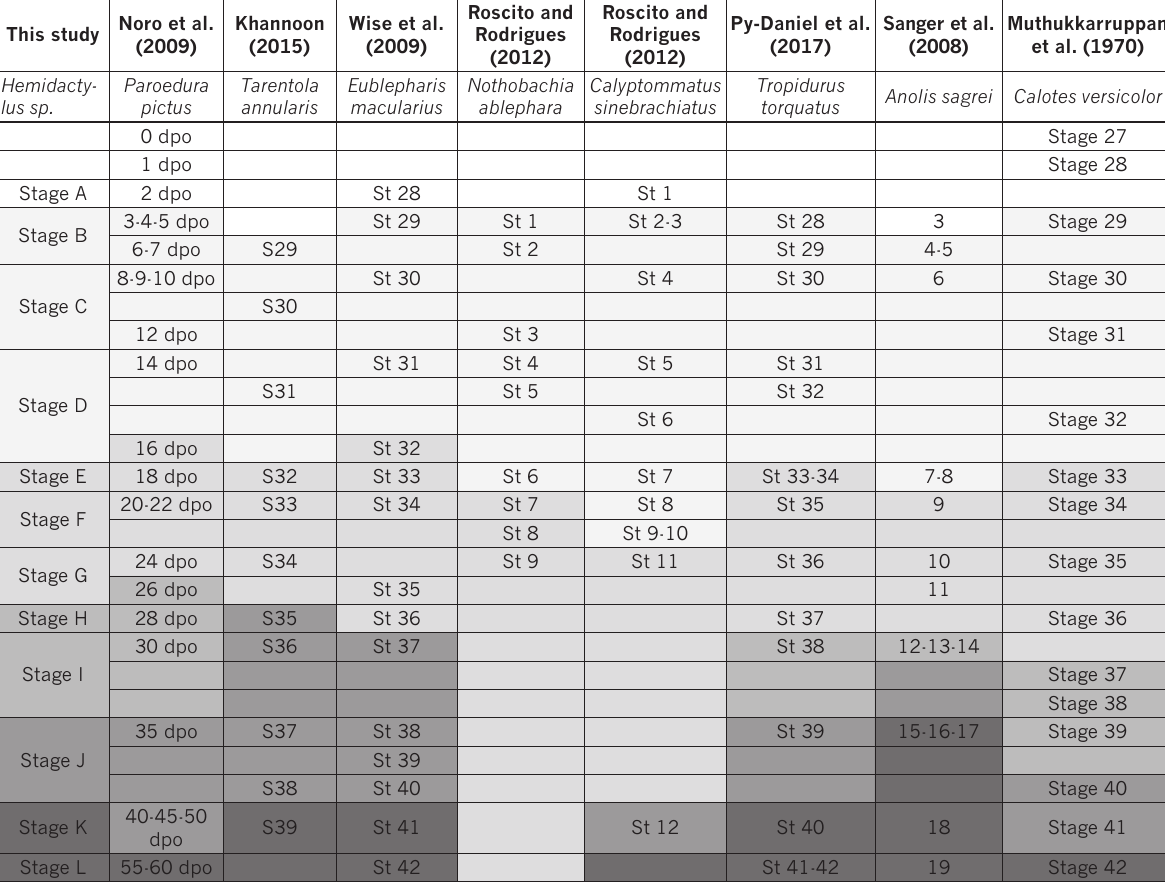
Table 3. Comparison of squamate staging tables. Differing stages were horizontally aligned based on key characters. Comparing different staging tables allows for the study of heterochrony within squamates, here including geckos, lacertids and iguanians. Fo - cused on limb development, darkening shades of gray indicate (i) both limb buds present after oviposition, (ii) interdigital tissue starts retreating, (iii) develops claws on all 5 digits, (iv) first sign of scales on limbs, and (v) limbs fully developed apart from size. Abbreviations: dpo – days post-oviposition; S, St – embryonic